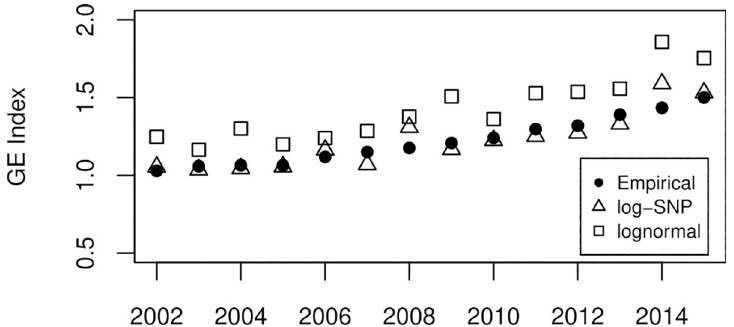
Fig 4. Dynamics of the empirical and theoretical value of the GE index. The figure compares the time evolution of the empirical values of the GE index with alpha = 0 (solid circle) and the theoretically estimated values under a lognormal (square) and log-SNP (triangle)